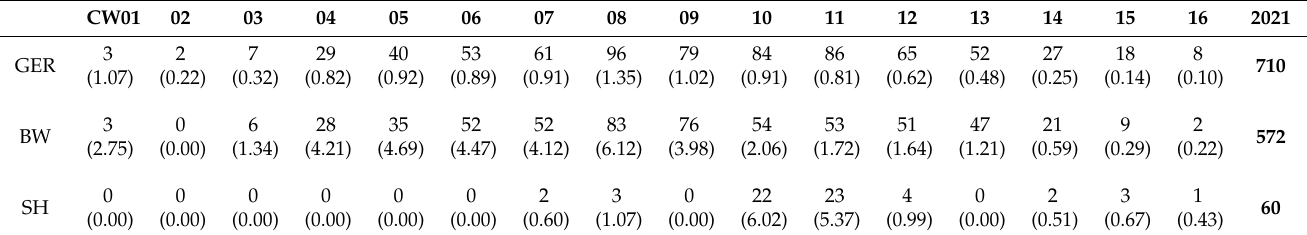
Table 1. The number of detected A.27 whole-genome sequences by calendar week (CW) until 2 May 2021 that were either submitted to the RKI via DESH ( n = 707) or directly sequenced at the RKI as part of the IMS-SC2 ( n = 3). Data from a random and suspect sampling strategy are combined. Relative frequencies (in %) in relation to all sequences from the respective CW are given in parentheses. Later time periods may be biased due to missing data. GER—All of Germany, BW—federal state of Baden-Wuerttemberg, SW—federal state of